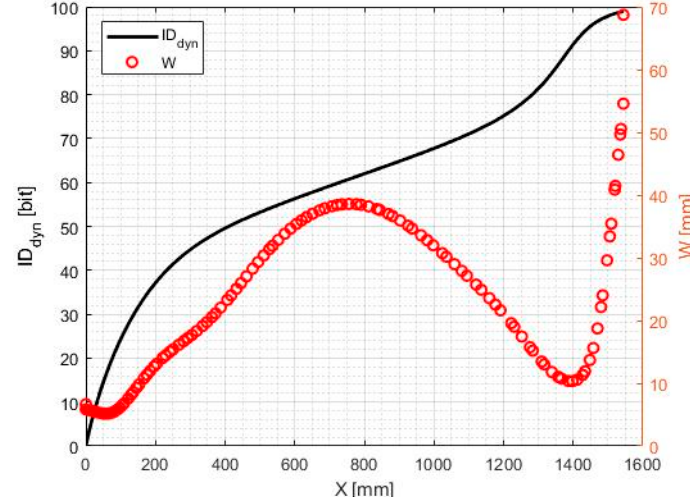
Figure 5. Cumulative Index of Difficulty ID agent ( x , ϕ = 0.96 ) and local affordance limits W ( x , ϕ = 0.96 ) evaluated at each point of the ankle path during a forward stride of the swing foot, from flat foot to heel strike. The specific agent is a 61-year-old healthy subject walking at an average speed of 1.584